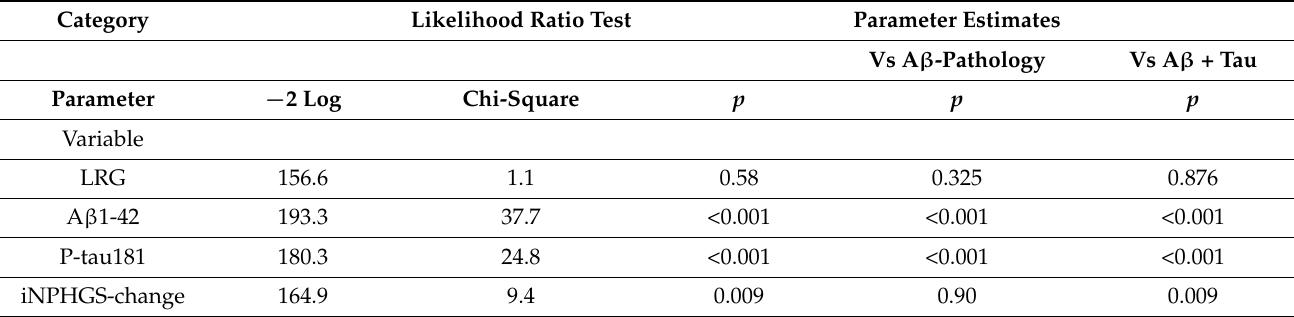
Table 4. Multi-nominal logistic regression results for Alzheimer’s disease (AD)-pathologies.